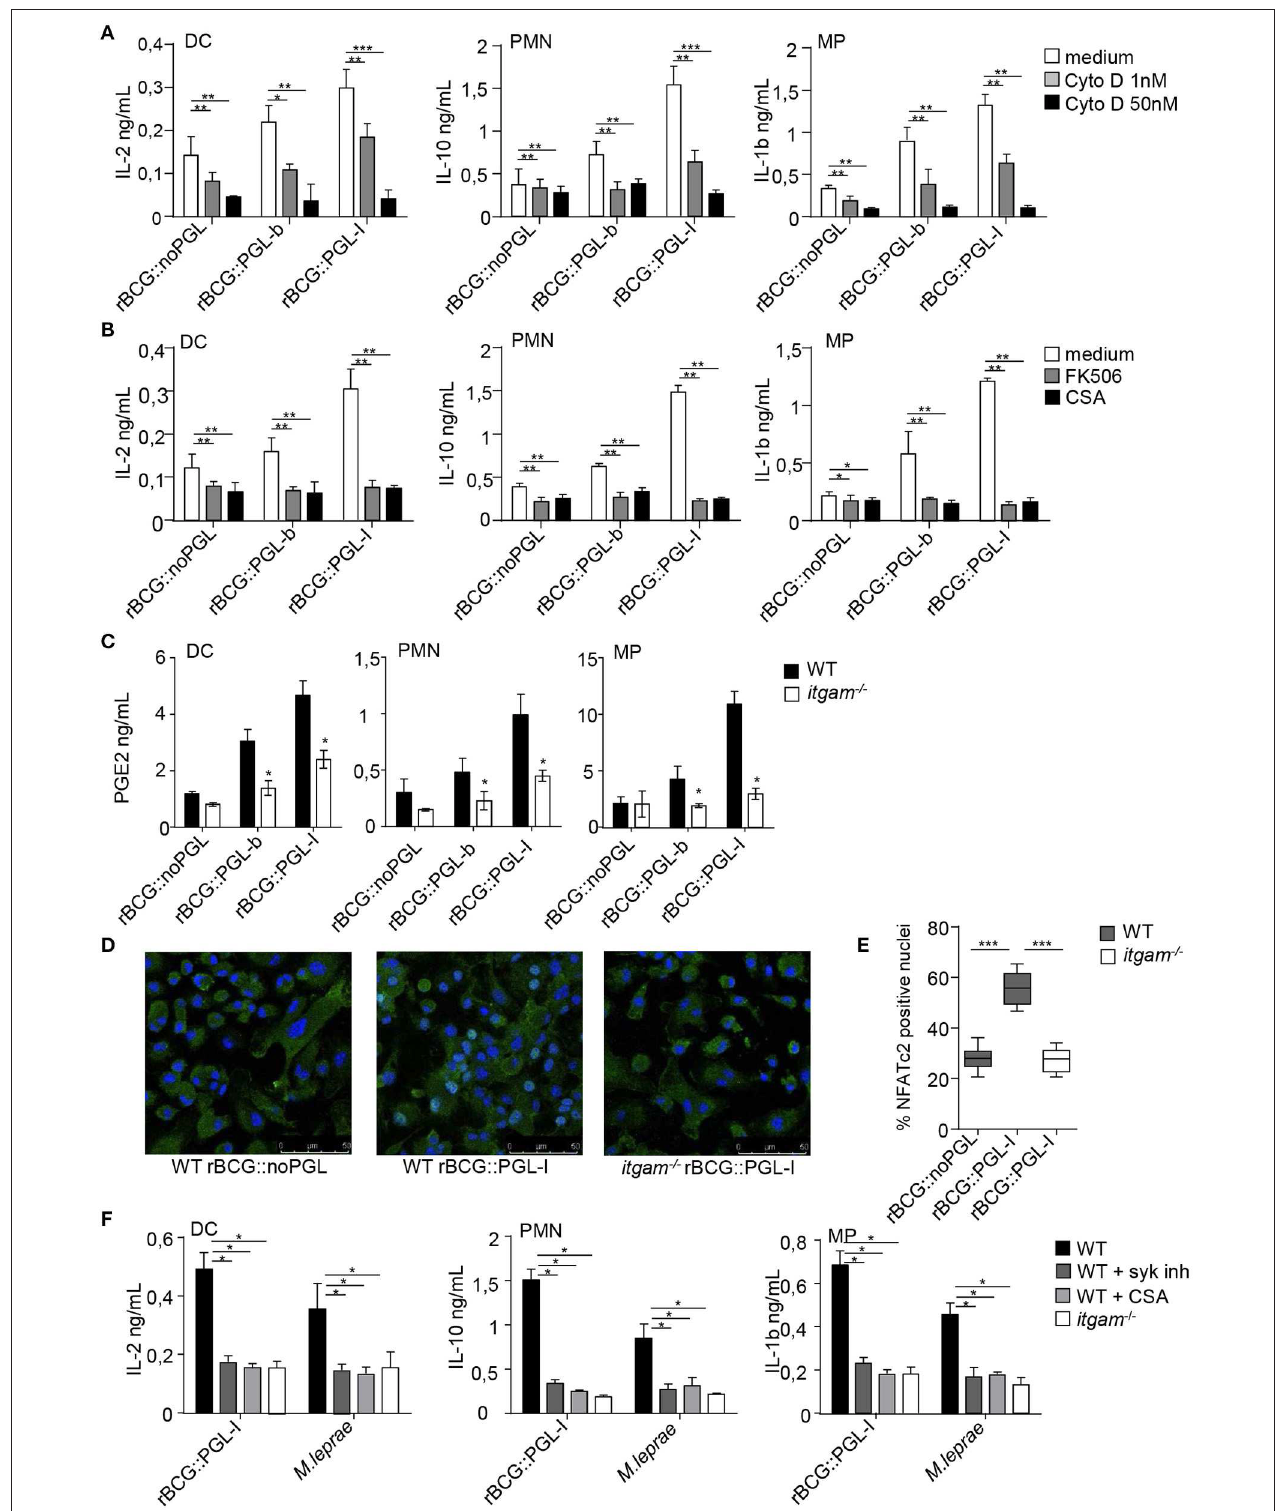
FIGURE 4 | PGL-I targeting of CR3 triggers nuclear translocation of NFATc2 downstream of Syk that controls a specific mediator signature. (A,B) IL-2 produced in DCs supernatants, IL-10 in PMNs and IL-1 β in MPs were measured by ELISA and (C) PGE2 by competition ELISA after overnight incubation the three